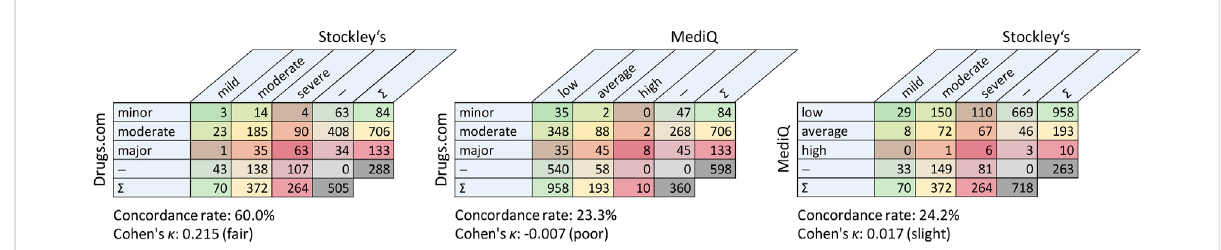
FIGURE 3 Pairwise comparisons of the databases in terms of reported potential drug-drug interactions by degree of severity. The crosstabs show the overlaps related to different pDDIs. The cells in the tables are color-coded according to pDDI severity from mild (green) to severe (red). — = not recorded in one of the two databases; (cid:1) = sum per row/column; pDDI, potential drug-drug